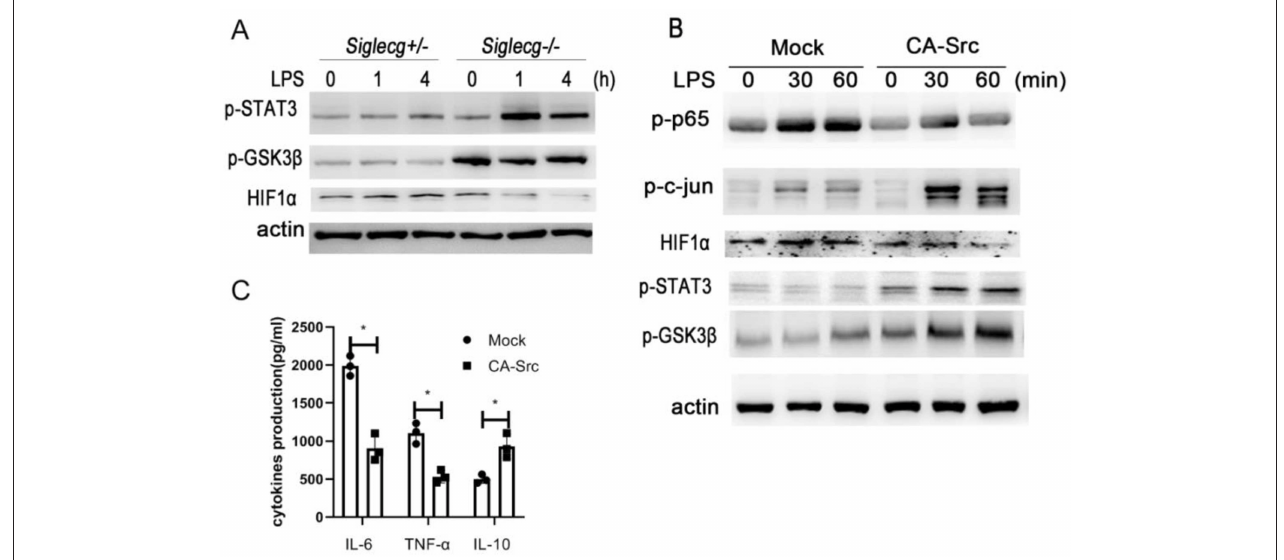
FIGURE 6 | Siglec-G orchestrates TLR4-induced STAT3 and HIF1 α activation via Src. (A,B) Immunoblotting of cell lysates from Siglecg + / − and Siglecg − / − peritoneal macrophages or RAW264.7 cells overexpressing CA-Src stimulated with LPS (100ng/ml) for indicated time with indicated antibodies. (C) ELISA of IL-6, TNF- α , and IL-10 in supernatant from constitutively active Src (CA-Src) overexpressing RAW264.7 cells stimulated with LPS (100ng/ml) for 12h. Data are representative of three independent experiments with similar results as means ± SD. * P < 0.01. TLR, toll-like receptor; LPS, lipopolysaccharide; IL, interleukin; TNF- α , tumor necrosis factor- α .